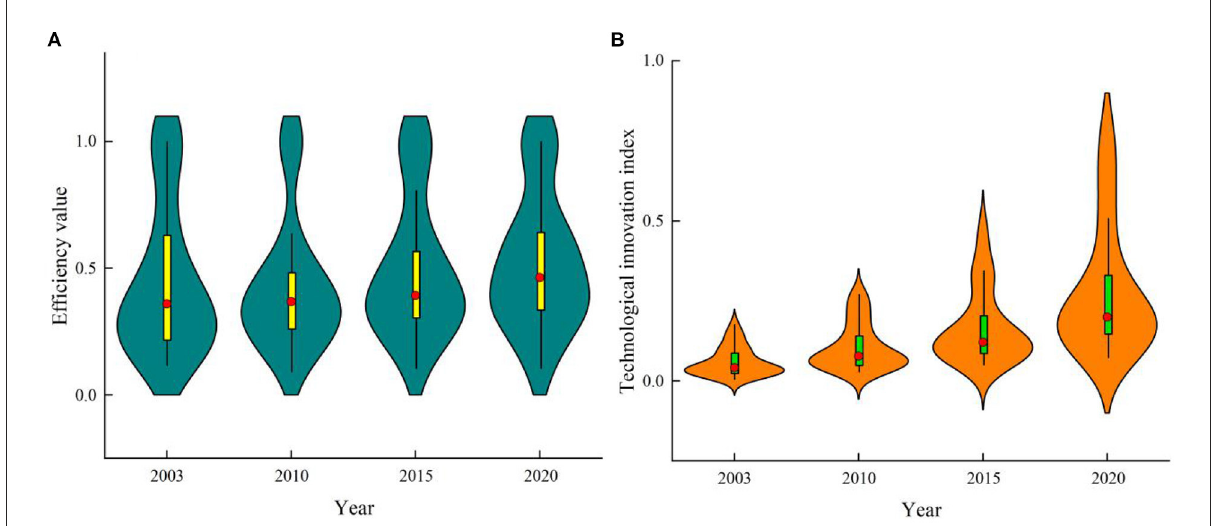
FIGURE1 Time-varying trend of TCEE and technological innovation index in China. (A) Transport carbon emission efficiency. (B) Technological innovation index.